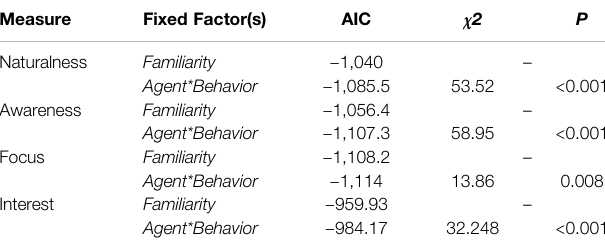
TABLE 2 | Detailed Akaike ’ s Information Criterion (AIC) of models for each